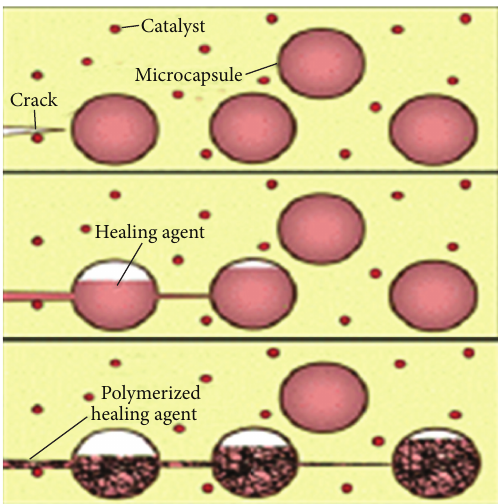
Figure 4: Basic method of the microcapsule approach (White et al., 2001) Source: